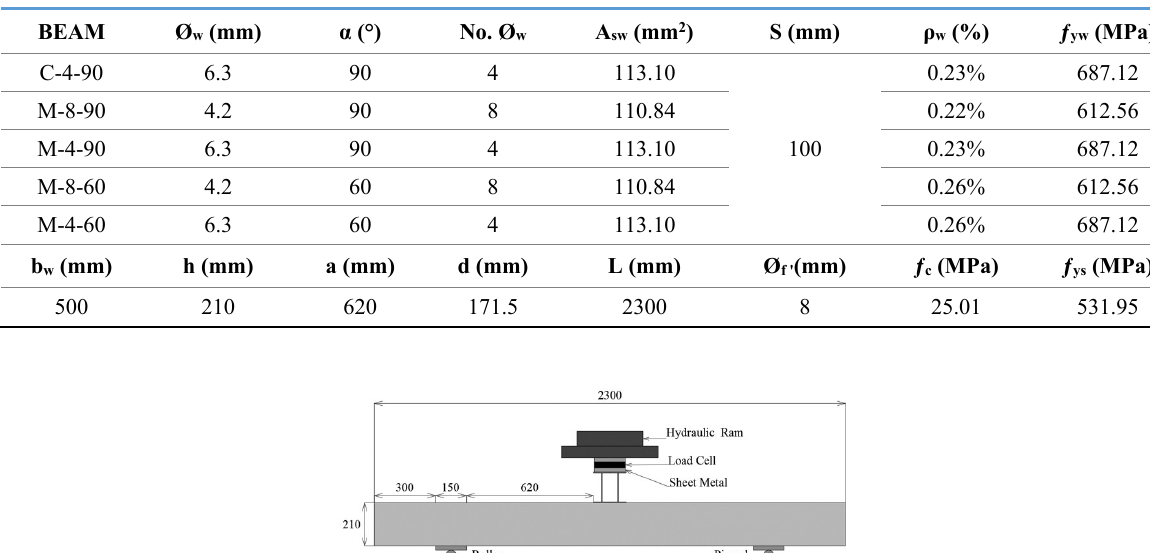
Table 1 - Characteristics of the tested beams